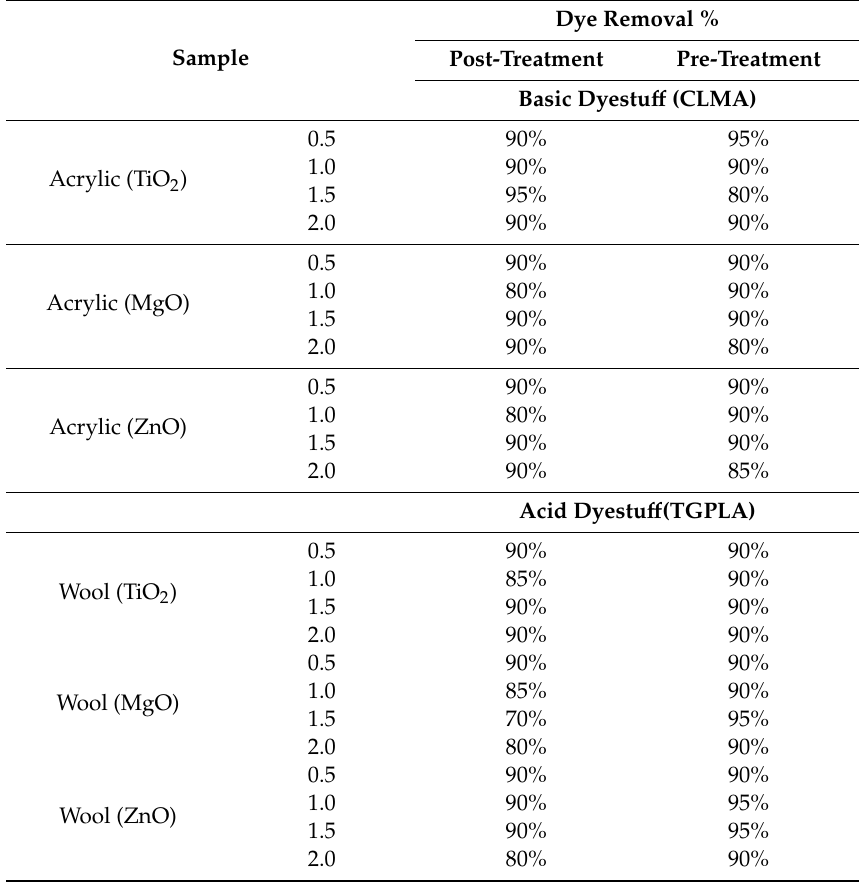
Table 9. Self-cleaning activity of wool and acrylic samples screen-printed with CLMA or TGPLA thickening agents and pre / post-treated with metal oxide